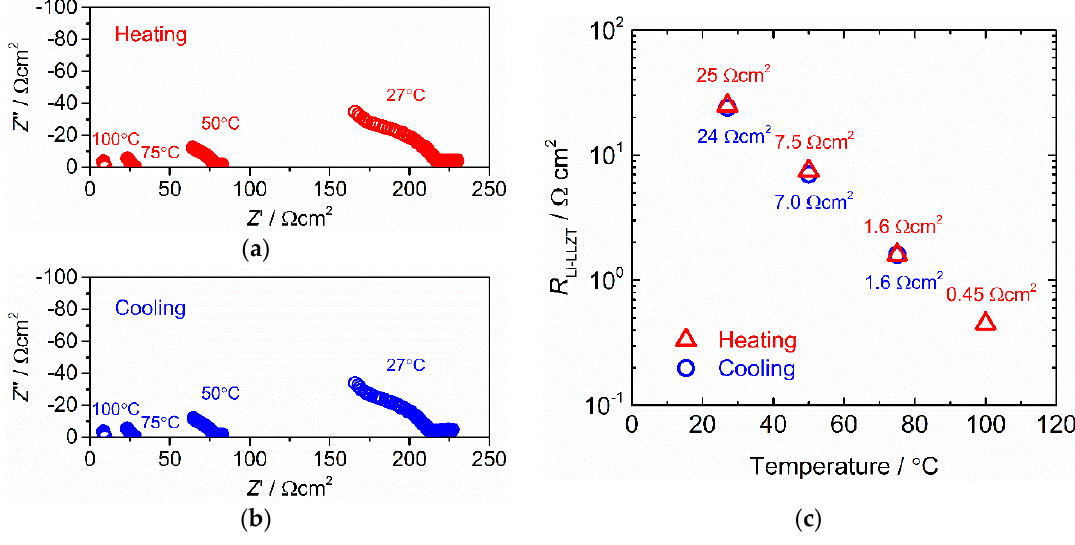
Figure 5. A/C impedance measured at different temperatures for Li/LLZT/Li symmetric cells after heat treatment at 175 °C for five hours: ( a ) during heating process from 27 to 100 °C and ( b ) cooling process from 100 to 27 °C. ( c ) Interfacial charge transfer resistance R Li-LLZT as a function of temperature.